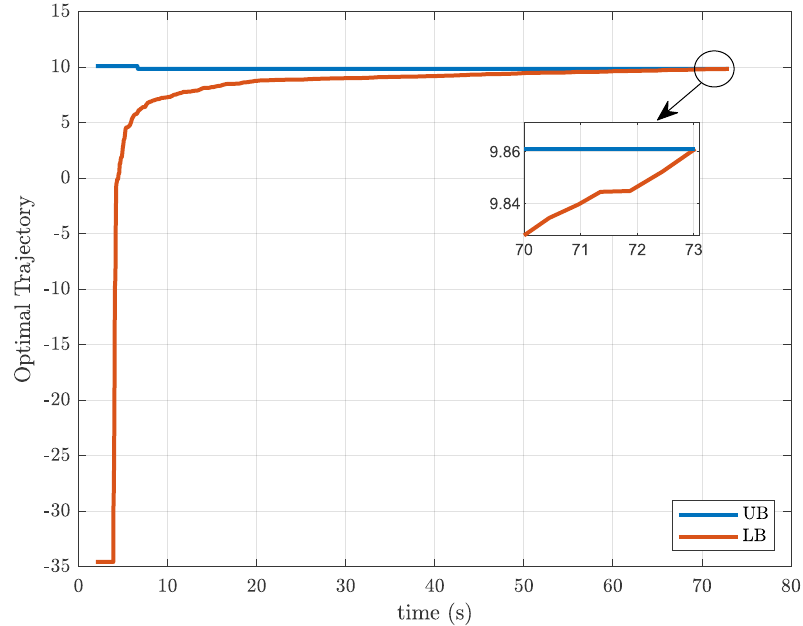
Figure 2. Trajectory of the bounds yielded by the Benders decomposition solution, for problem M = 8 and T = 6.